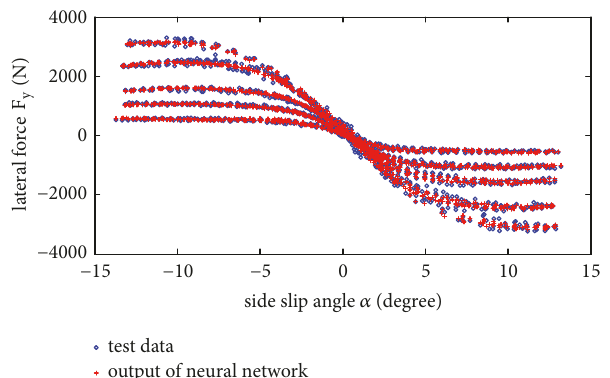
Figure 9: Comparisons between test data and output of the neural network.